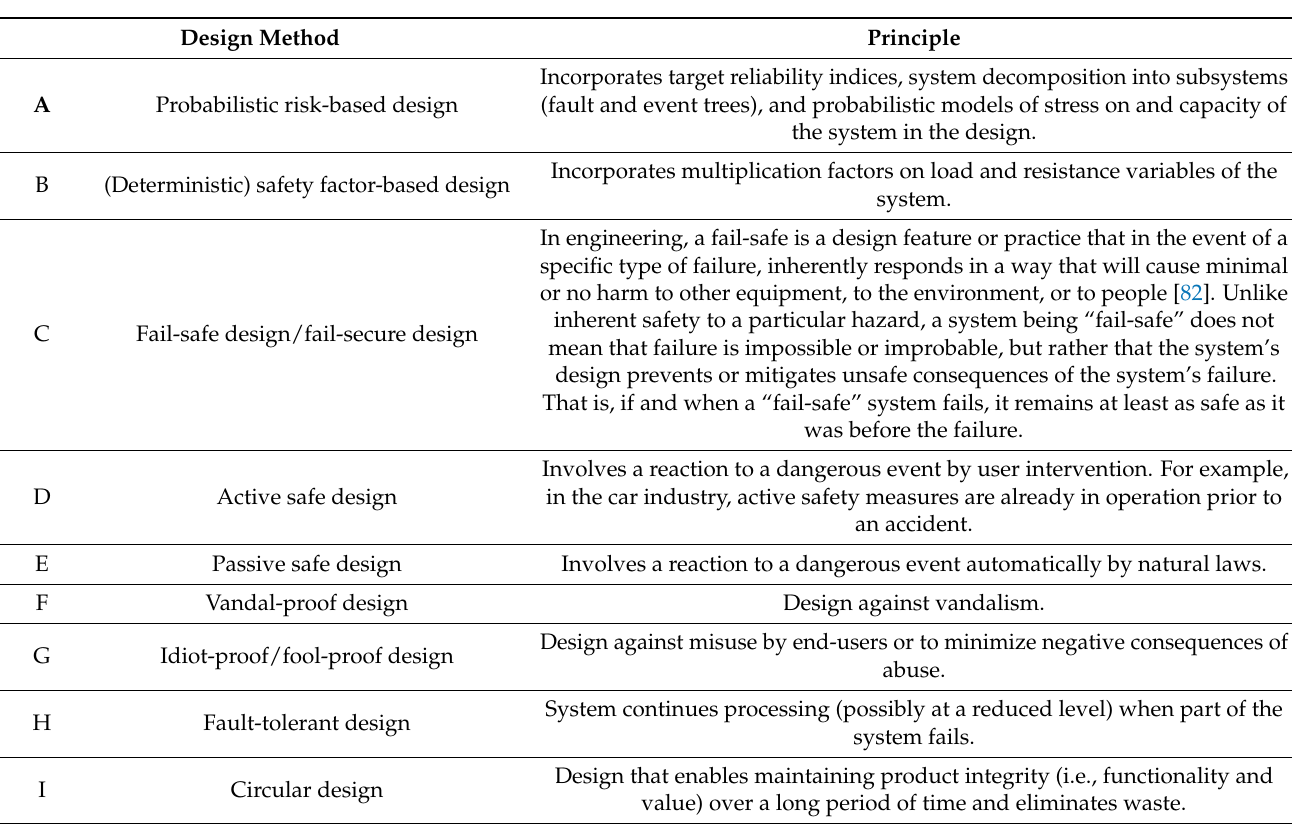
Table 1. Design strategies and associated